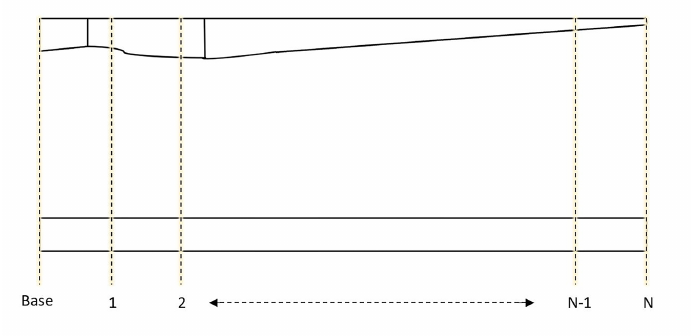
Figure 2. Section’s estimated diagram from the blade to the